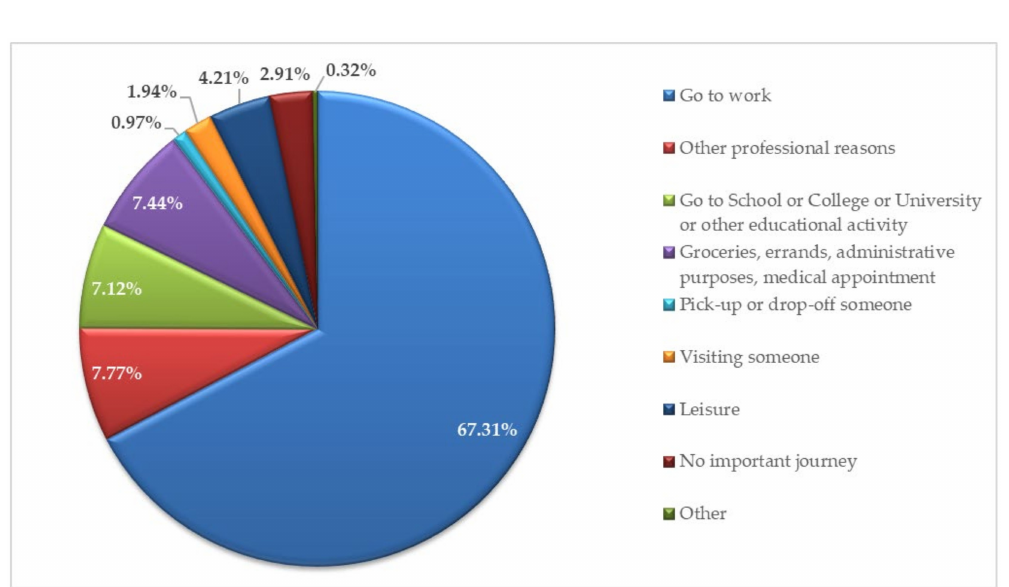
Figure 1. Purpose of main trip (Source: Authors’ survey data